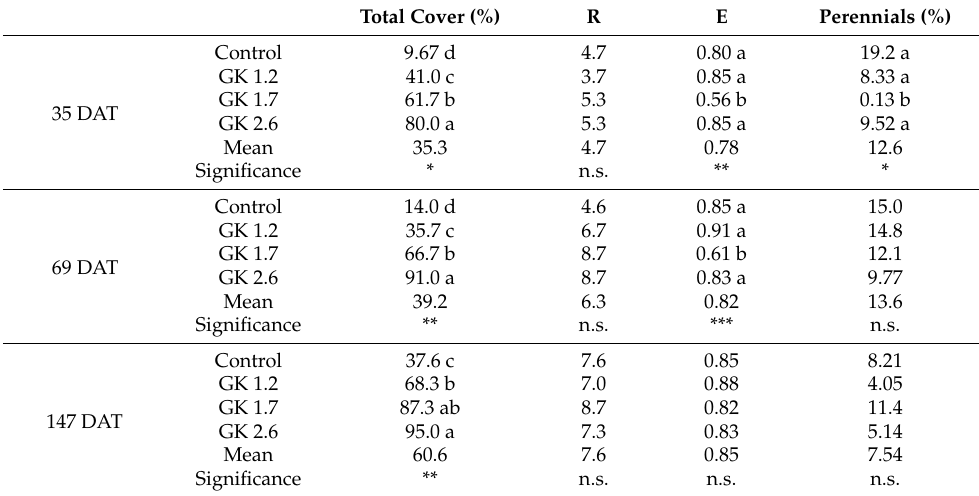
Table 3. Weed community structure at 35, 69 and 147 days after the tested weed control practices (second test, November